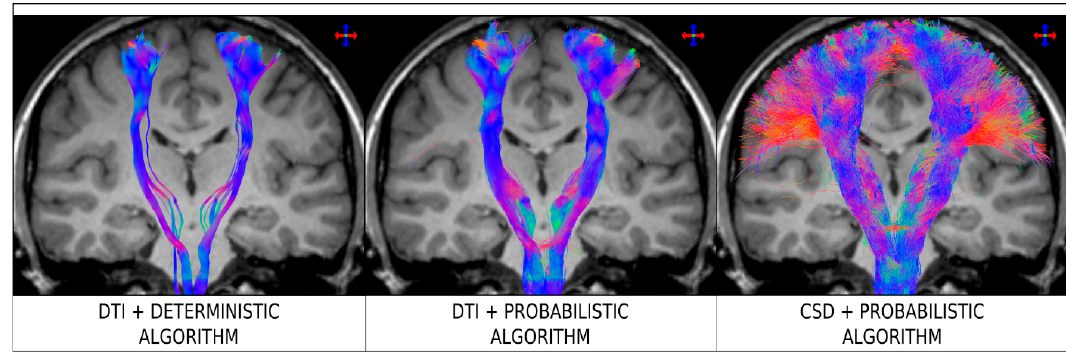
Figure 2. Fibre-tracking results on a healthy human subject obtained using a seed region in the brainstem and target region in the sensorimotor cortices. Coronal T1-weighted images overlaid with tractography results for Di ff usion Tensor Imaging (DTI) combined with a deterministic algorithm (left), DTI combined with a probabilistic algorithm (middle), and constrained spherical deconvolution (CSD) combined with a probabilistic algorithm (right). Data were acquired using 60 di ff usion-weighted directions with b = 3000 sec / mm 2 . The colour-coding indicated the fibre orientation (same convention as in Figure 1). Figure modified from a figure previously published in [30], with permission of